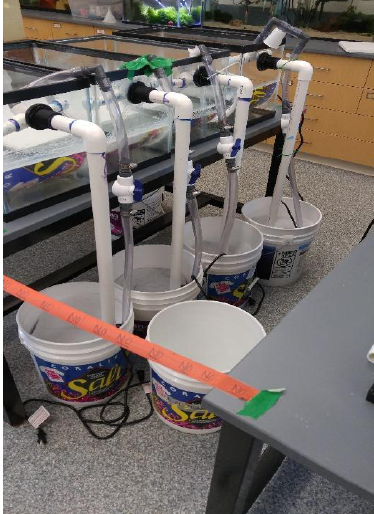
Figure 2. Pictures how the sides of the tank are curved.